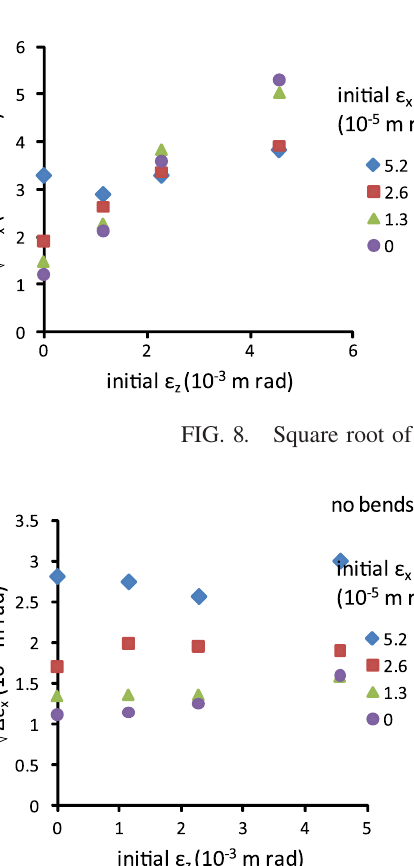
and (cid:1) , runs with bends x z